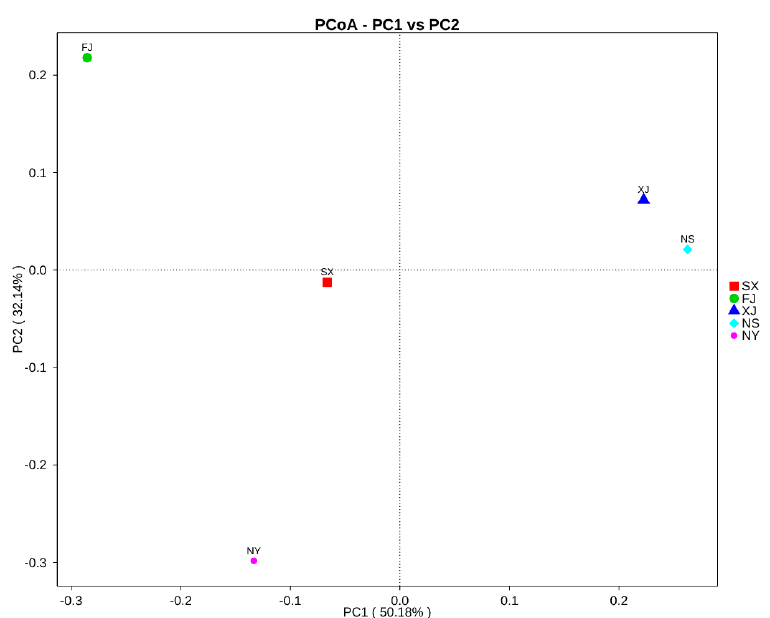
Figure 8. Principal coordinate analysis (PCoA) plot based on unweighted Unifrac metrics for all samples.